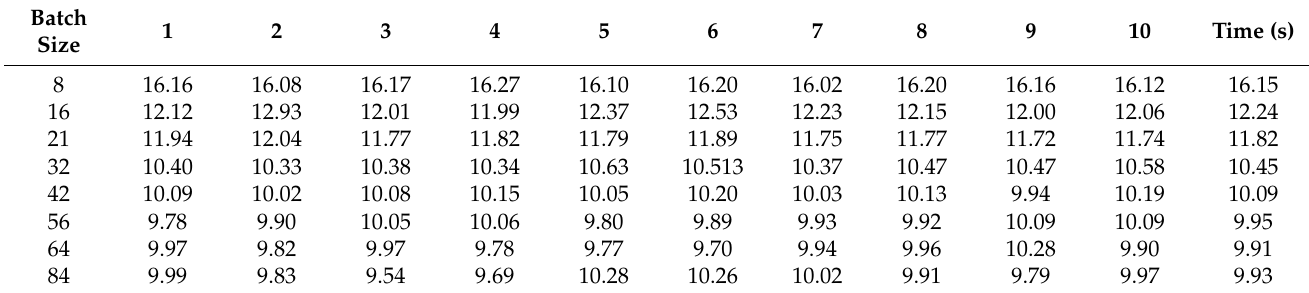
Table 1. Computational time of different batch sizes in one epoch.